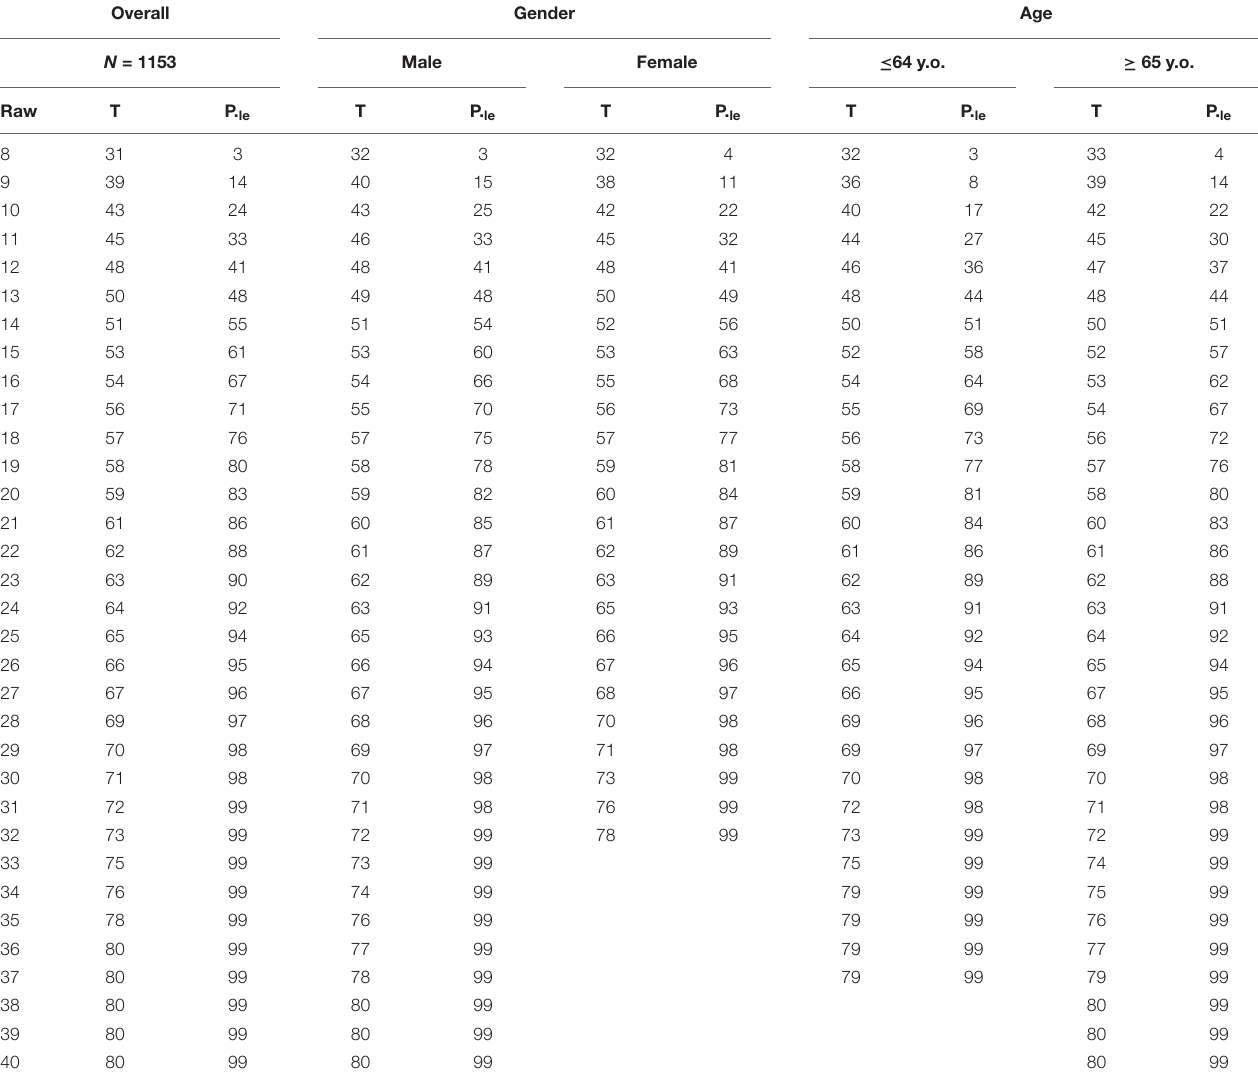
TABLE 5 | Study 1 plus Study 2. Normative scores (T-scores) and percentile distribution.